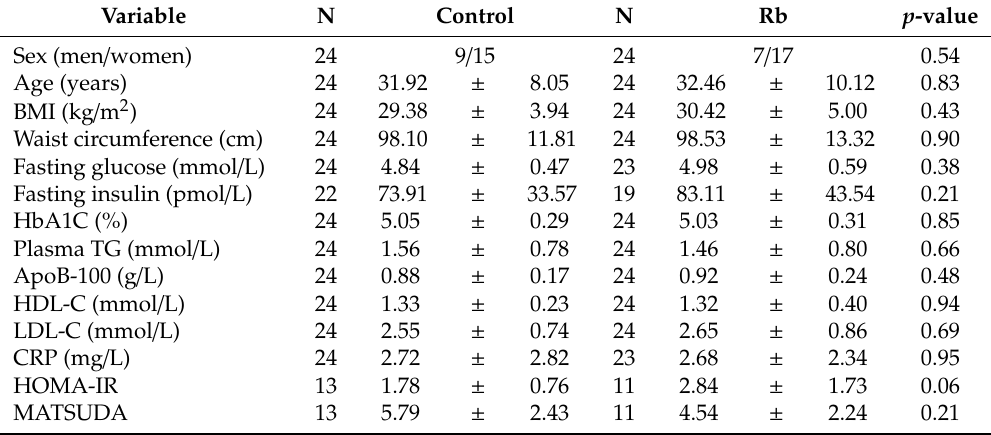
Table 1. Clinical and laboratory baseline characteristics of study